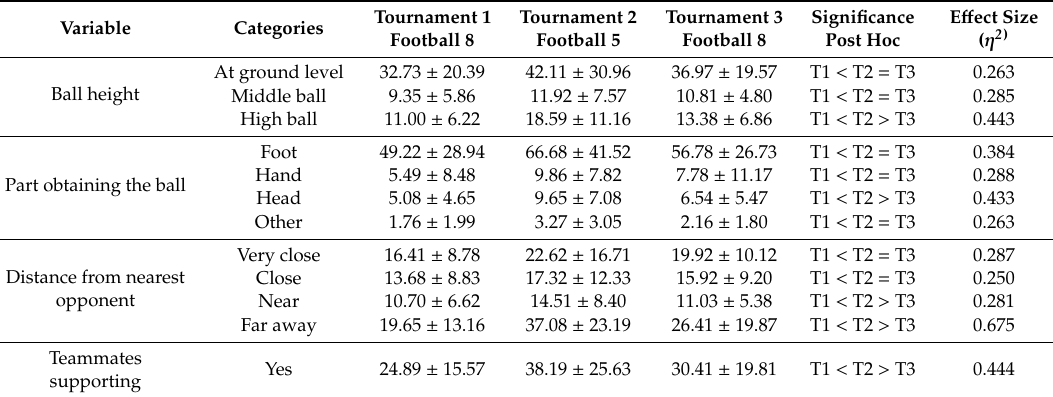
Table 3. Technical–tactical aspects in the obtaining of the